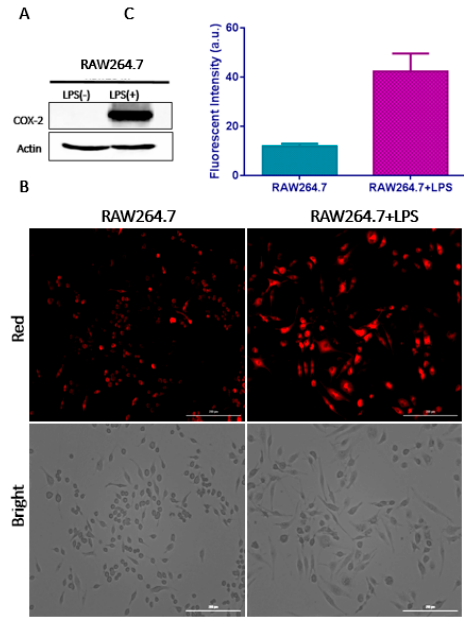
Figure 6. ( A ) Western blot showing COX-2 expression level of RAW 264.7 cells treated with lipopolysaccharide (LPS) (1 µ g / mL), which induced the COX-2 expression level. ( B ) Fluorescent images of RAW 264.7 and inflamed RAW 264.7 cells. Fluorescence images of LPS-induced inflamed cell lines (RAW 264.7 cells). Cells were incubated with LPS (1 µ g / mL) for 12 h, followed by CCY-5 treatment (1 µ M) for 2 h ( λ ex: 628 nm; Red, λ em: 685 nm; All the images share the same scale bar: 200 µ m). ( C ) Quantitative image analysis of the average total fluorescence intensity of RAW 264.7 cells (n = 3). * p < 0.05.